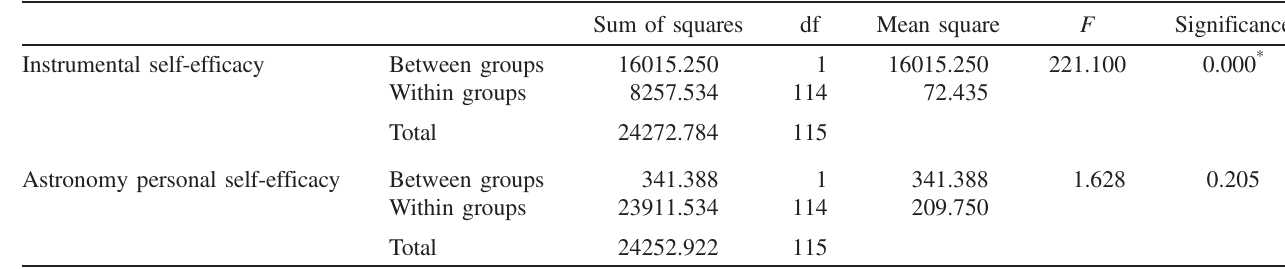
TABLE VIII. One-way ANOVAs of the APSE and ISE between cohort A and cohort